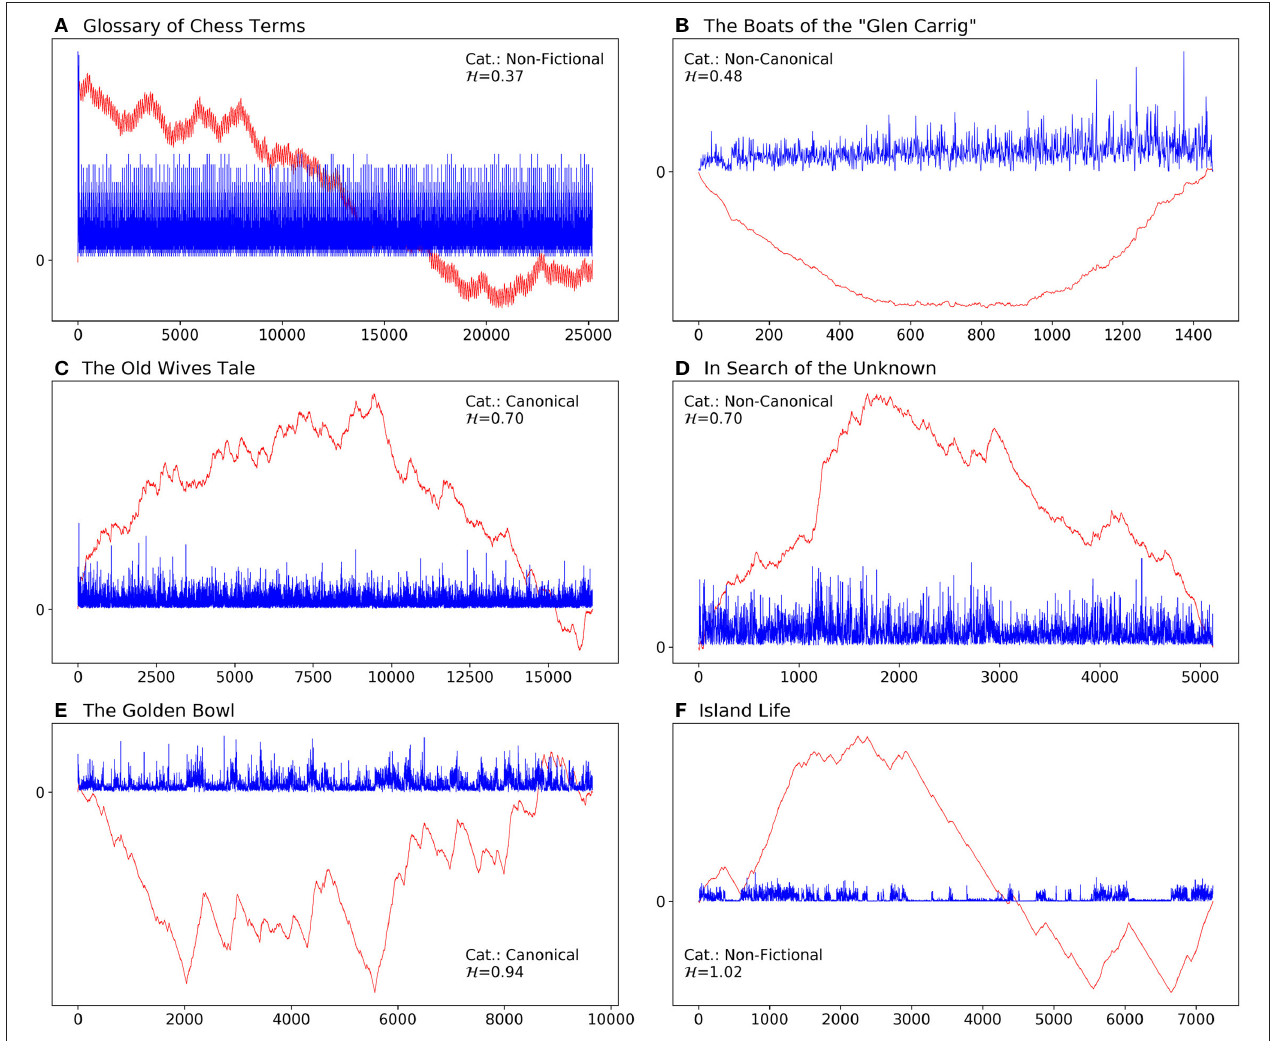
FIGURE 1 | Sentence length series (blue) and their profiles (red; cumulative sum of mean centered series) of some example texts in the corpus. The series have been scaled up by a factor of 20 to show more detail. The category (Cat.) and the fractal degree, H , of each text is shown inside each panel. (A) Glossary of Chess Terms by Gregory Zorzos, with the lowest fractal degree in our corpus. (B) Boats of the “Glen Carrig” by William Hope Hodgson with H = 0.48, a non-canonical text with the lowest value among the fictional books. (C) Women in Love by D. H. Lawrence, the median of canonical texts. (D) In Search of the Unknown by Robert W. Chambers, representing the median of non-canonical texts. (E) The Golden Bowl by Henry James, with the highest fractal degree among canonical texts. (F) Island Life by Alfred Russel Wallace, a non-fictional text, with the highest fractal degree in the whole corpus.